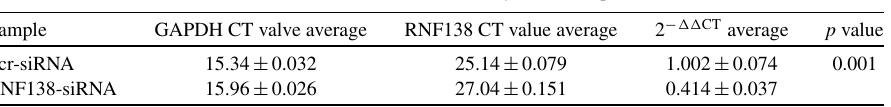
CT values of GAPDH and RNF138 detected by real-time quantitative PCR